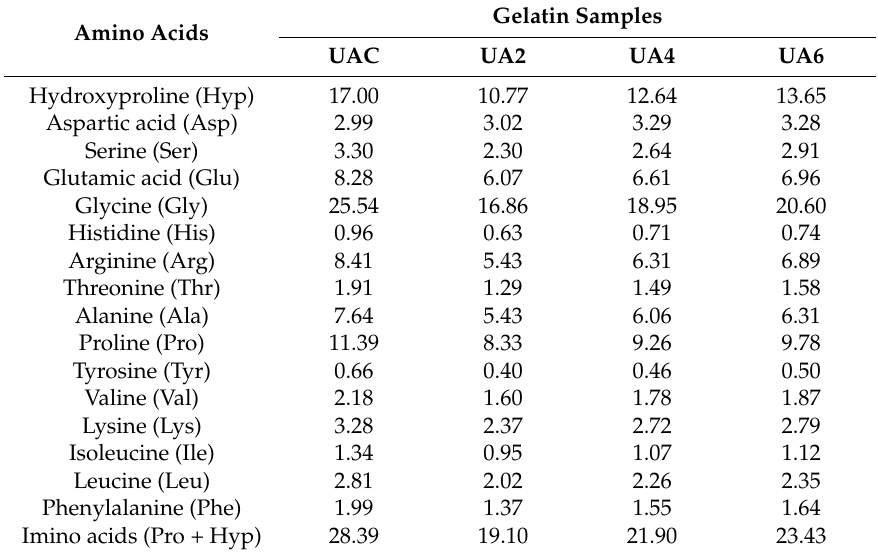
Table 3. Amino acid composition (per centof gelatin sample) of gelatin samples. UA2, UA4 and UA6 refers to gelatin extracted using ultrasound for the time duration of 2, 4 and 6 h, respectively from bovine hide pretreated with enzyme actinidin. UAC: control gelatin extracted using ultrasound without enzymatic